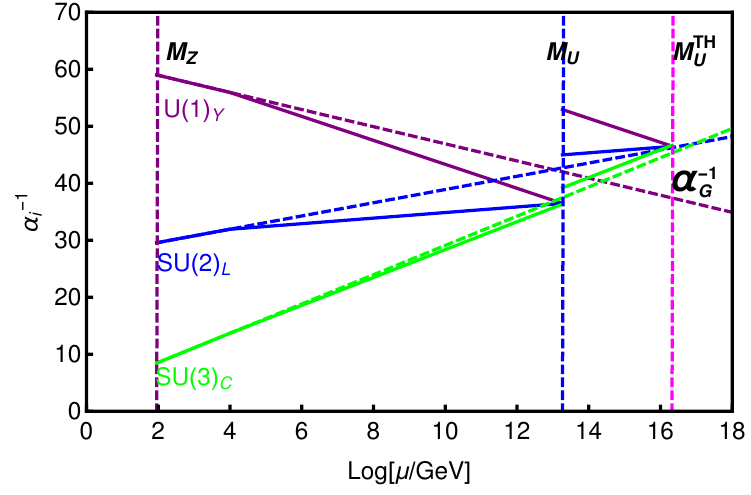
Figure 3 . Unification plot for all three gauge couplings, where the one-loop effects are displayed upto the mass scale M while the threshold effects are shown in the mass range M U